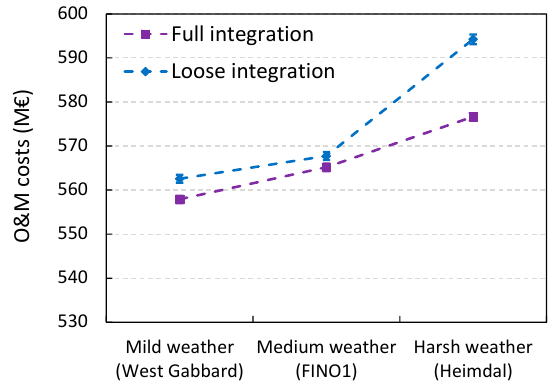
Figure 7. Results for O&M costs for different weather conditions.